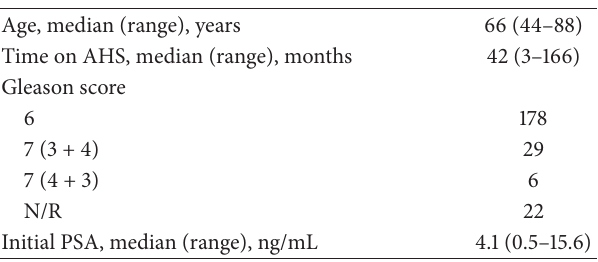
Figure 1: The average PSA of the total cohort while on AHS. Table 2: Patient demographics ( 𝑁 = 235 ).